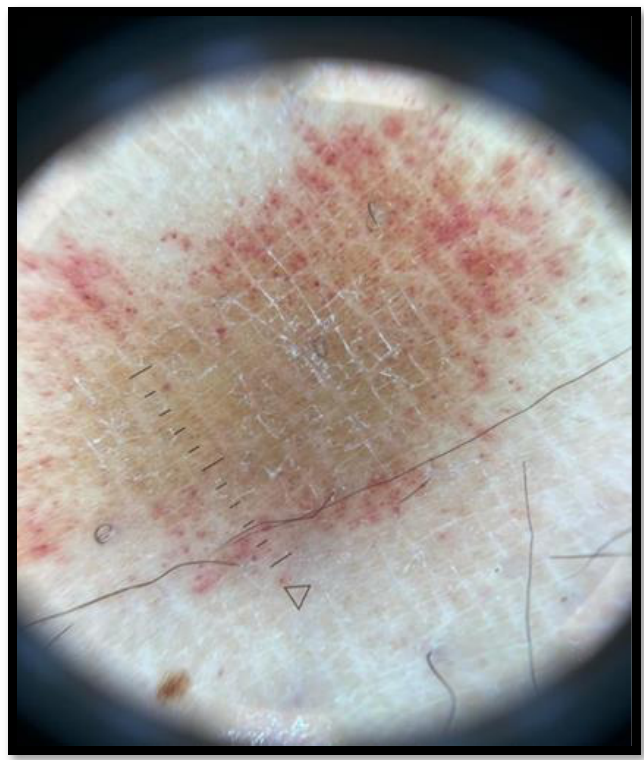
Figure 2. Dermoscopy: Capillaritis, reddish-brown dots-clods on a coppery-red background caused by leaky capillaries. Due to inflammation, blood cells may pass through small gaps between vessal walls’ cells, resulting in petechial hemorrhage.